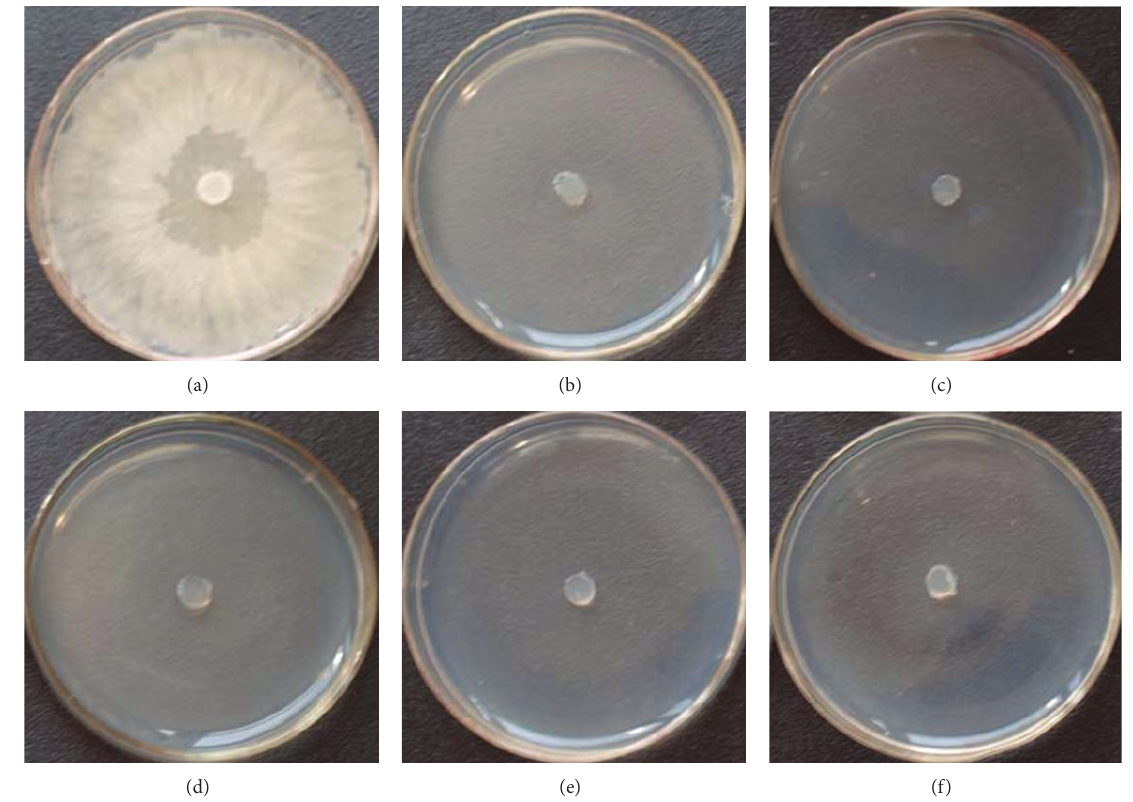
Figure 1: Growth of Valsa mali wild-type strain LXS240101 on PDA medium containing different concentrations of hygromycin B. LXS240101 shows normal growth on PDA plates without hygromycin B (a) and no growth on PDA plates containing 25, 50, 75, 100, and 150ug/mL hygromycin B (b–f). The plates were incubated at 25 ∘ C for seven